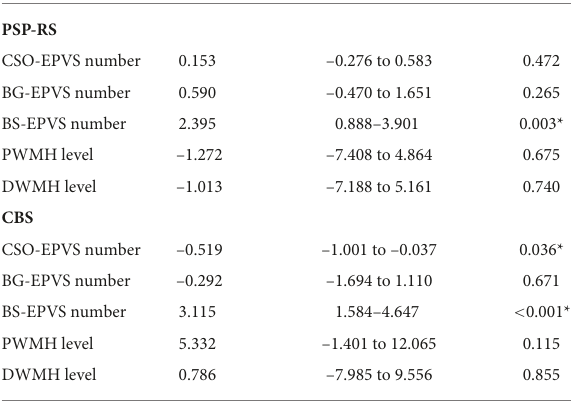
TABLE 3 Association of EPVS and WMH with PSPRS scores in PSP-RS and